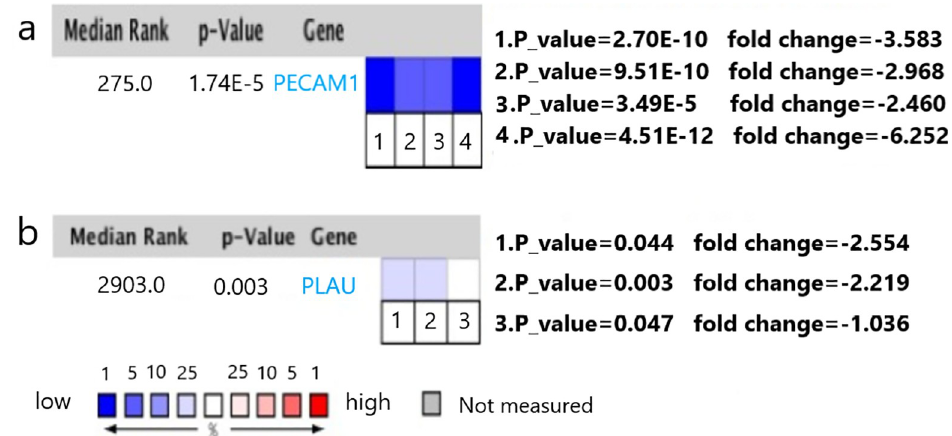
Fig 6. Oncomine analysis of (a) PECAM1 and (b) PLAU expression in PRCC samples vs. normal samples. Heat maps of PECAM1 and PLAU gene expression in clinical PRCC samples vs. normal samples. Red represents high expression, and blue represents low